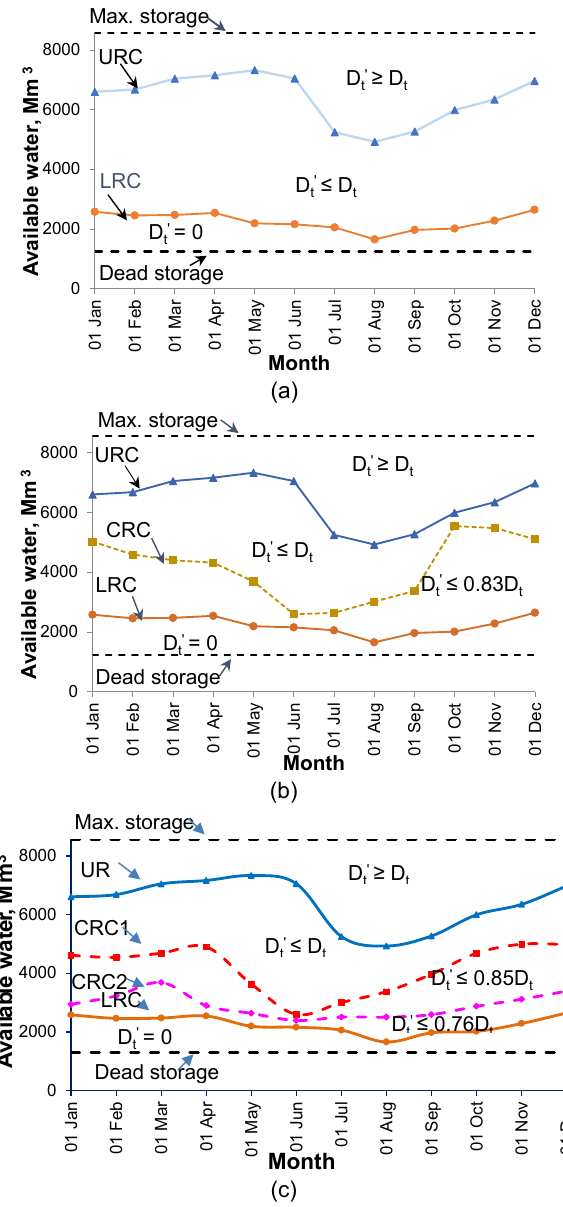
Figure 5. GA optimised rule curves (a) No hedging; (b) Single- stage constant hedging; (c) two-stage constant hedging.